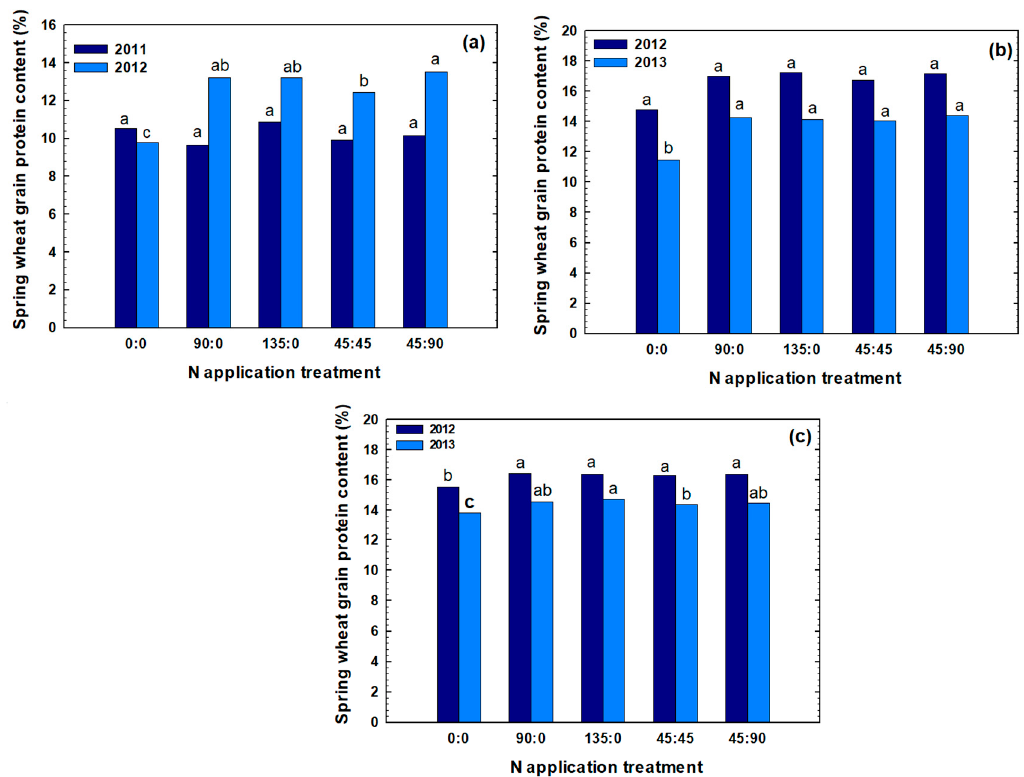
Figure 2. Effect of different rate and timings of N application on protein content (GP) of spring wheat in Pondera ( a ), Chouteau ( b ), and Teton ( c ) in two years. Treatments were designated in the format x:y where x and y are the fertilizer N rates in kg N ha − 1 applied at planting and at flowering, respectively. Bars within the same year that have the same letter are not significantly different ( p < 0.05) based on a Duncan’s multiple range test.